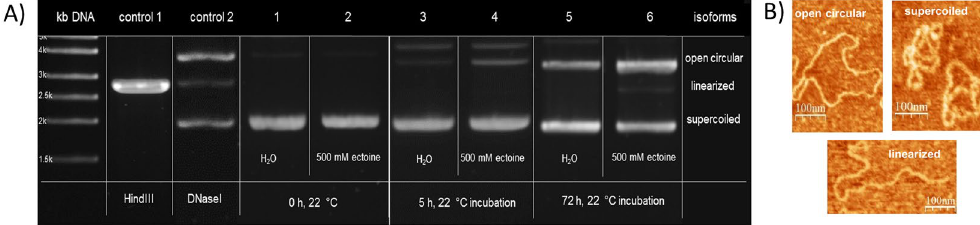
Figure 1. Representative images of pUC19 structures analyzed by gel electrophoresis and confirmed by AFM. ( A ) Electrophoretic mobility of pUC19 isoforms in 1% agarose gel: control (1) Hin dIII endonuclease digested pUC19, which results in linearized isoform after one double strand break; control (2) pUC19 unspecifically digested with DNaseI, which leads to open circular and linearized plasmid isoforms; (1–6) pUC19 under specific conditions (H 2 O or 500 mM ectoine solution at 22 °C) and incubation times are as indicated in the figure. ( B ) Isoforms of pUC19 confirmed by AFM:supercoiled (undamaged), open circular (single-strand break), linear (double-strand